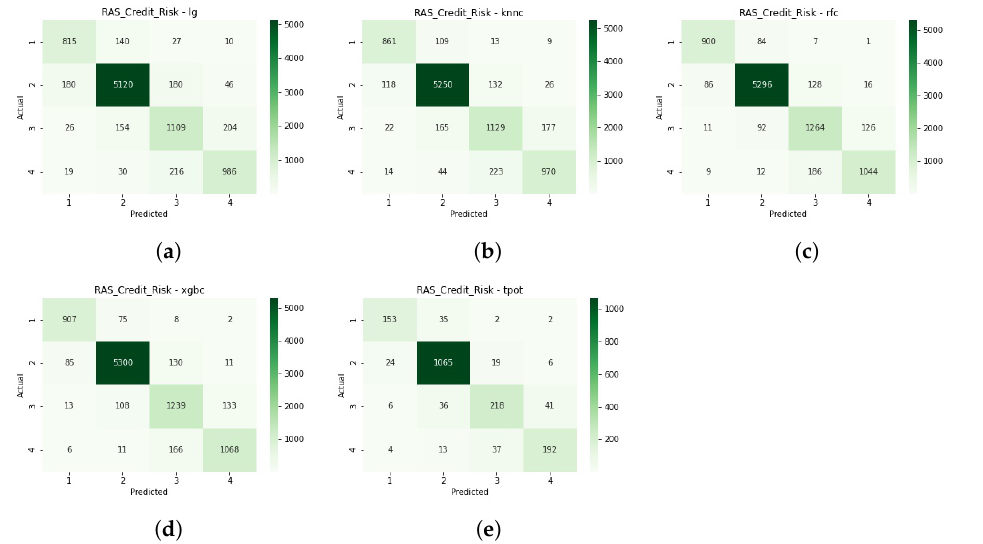
Figure A2. Credit risk: confusion matrices generated when evaluating the above-mentioned models, using cross-validation approach.( a ) Logistic Regression. ( b ) k-Nearest Neighbours classifier. ( c ) Ran- dom Forest classifier. ( d ) Extreme Gradient Boosting classifier. ( e ) TPOT classifier autoML